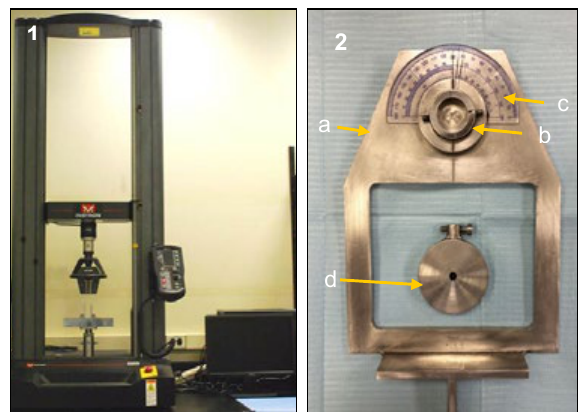
Figure 1. Photographs showing (1) Universal testing machine (Instron 5965), (2) Custom made mounting device. (a) Outer Aluminum block. (b) Inner holder. (c) Protractor. (d) 150-g weight. (e) Anterior-posterior adjusting base.